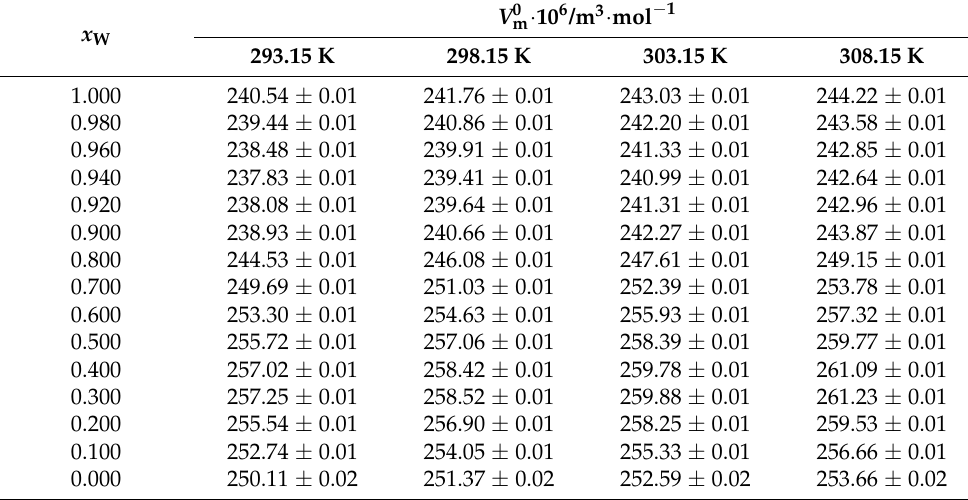
Table 1. Limiting partial molar volume of pentaglyme in the DMF + W mixed solvent.